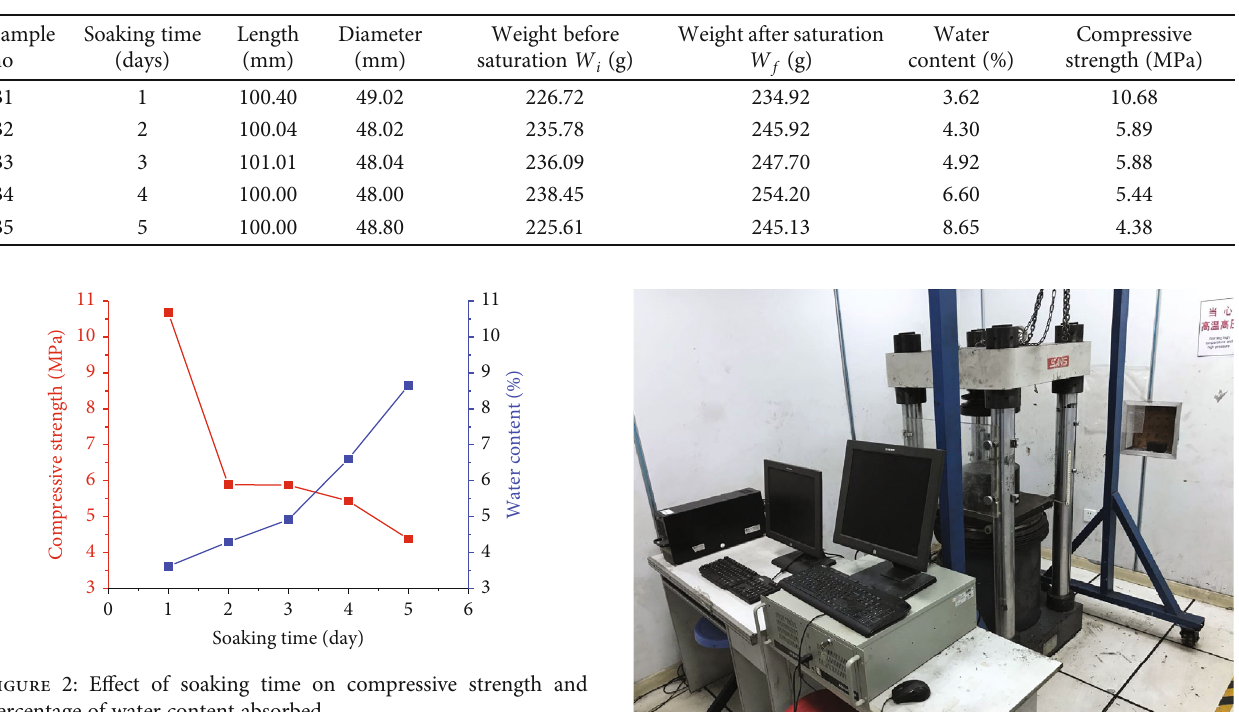
Figure 1: Coal samples with di ff erent soaking Table 1: Di ff erent properties of the coal samples.